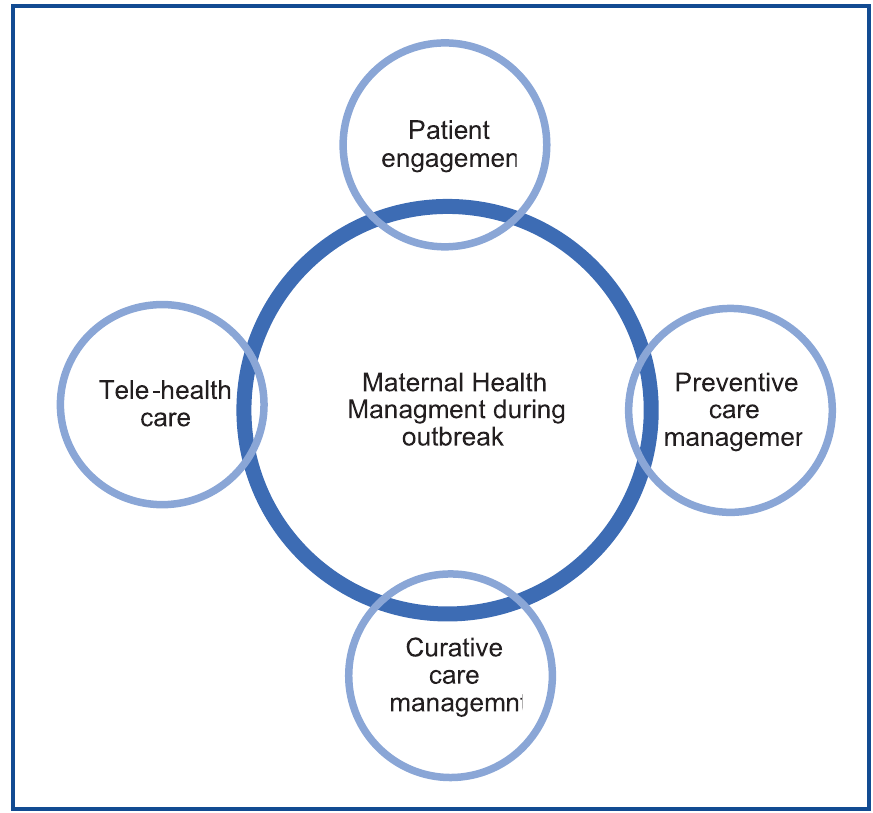
Figure 1: Integrated holistic maternal health management framework during COVID-19